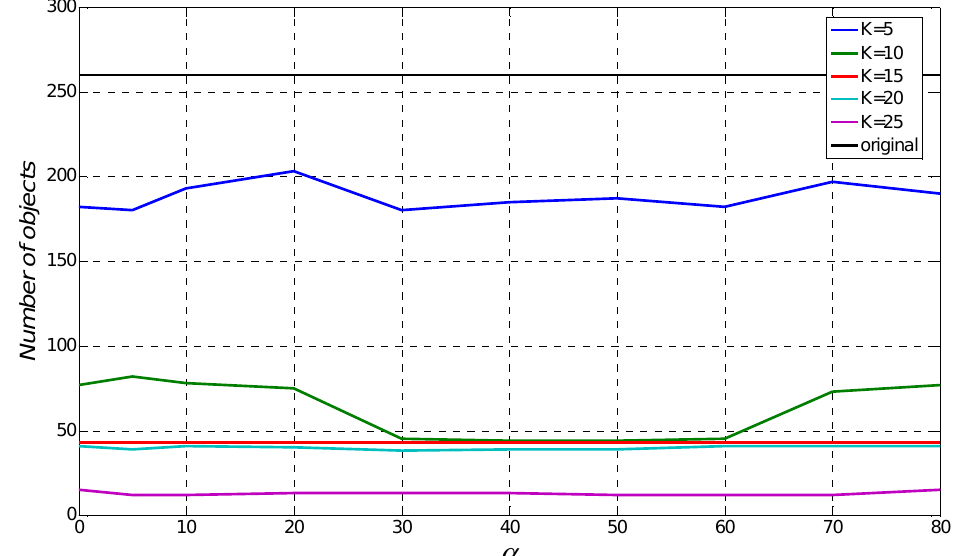
Figure 9. Number of the objects as a result of multi-line segmentation